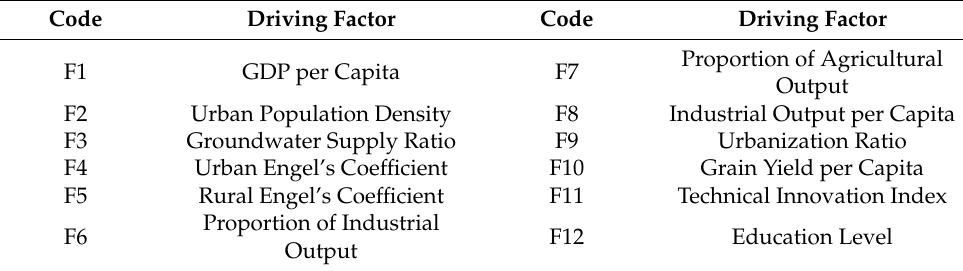
Table 3. Driving factors and